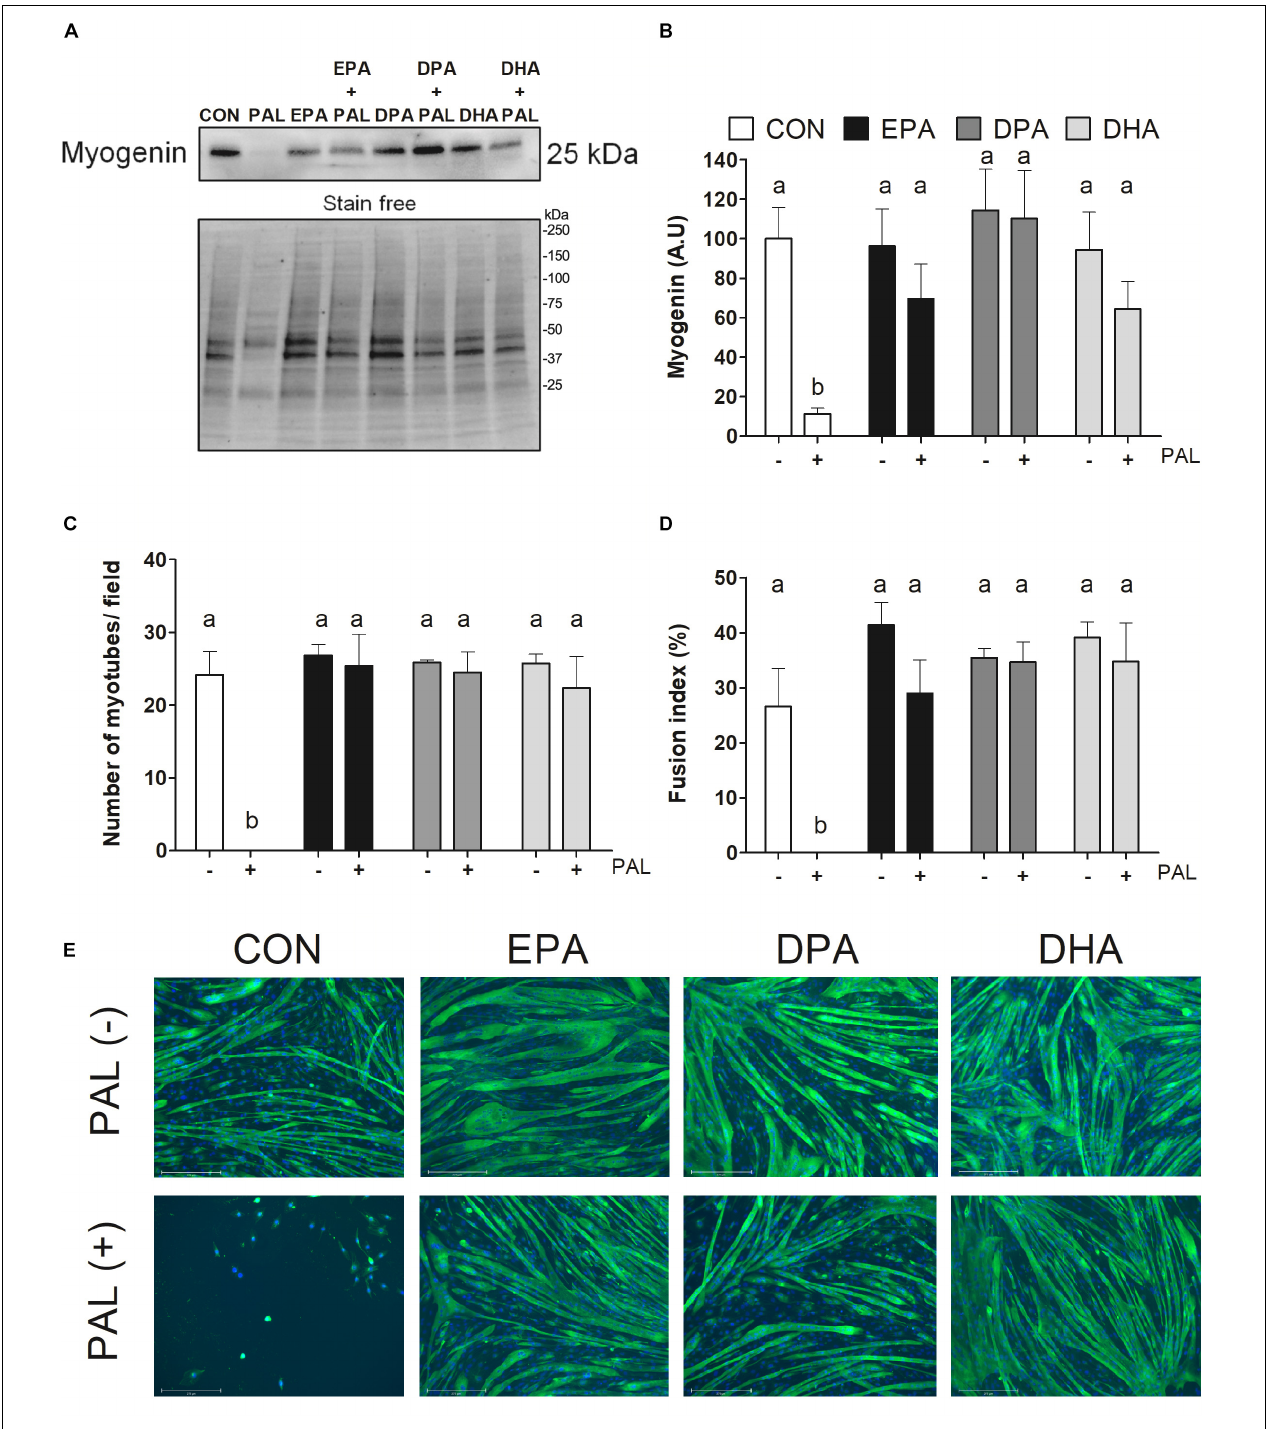
FIGURE 4 | EPA, DPA, and DHA protect against the inhibitory effects of PAL on myotube differentiation. Protein expression of the myogenic protein myogenin 120 h following treatment with 500 µ M PAL and/or 50 µ M EPA, DPA, or DHA, with a representative image of a stain free blot used for normalization shown with molecular weight markers indicated (A) . Quantified protein expression of the myogenic protein myogenin (B) . All densitometry values are expressed relative to protein content determined by stain free imaging and presented in arbitrary units relative to CON. Treatments that do not share letters are considered statistically significant ( p < 0.05; n = 6 biological replicates). Average number of myotubes/field (C) and fusion index (number of nuclei in tubes relative to the total number of nuclei expressed as a percentage) (D) . Representative images of each treatment group at 120 h ( n = 3 biological replicates) (E) . Scale bar represents 275 µ m. Values are presented as mean ±